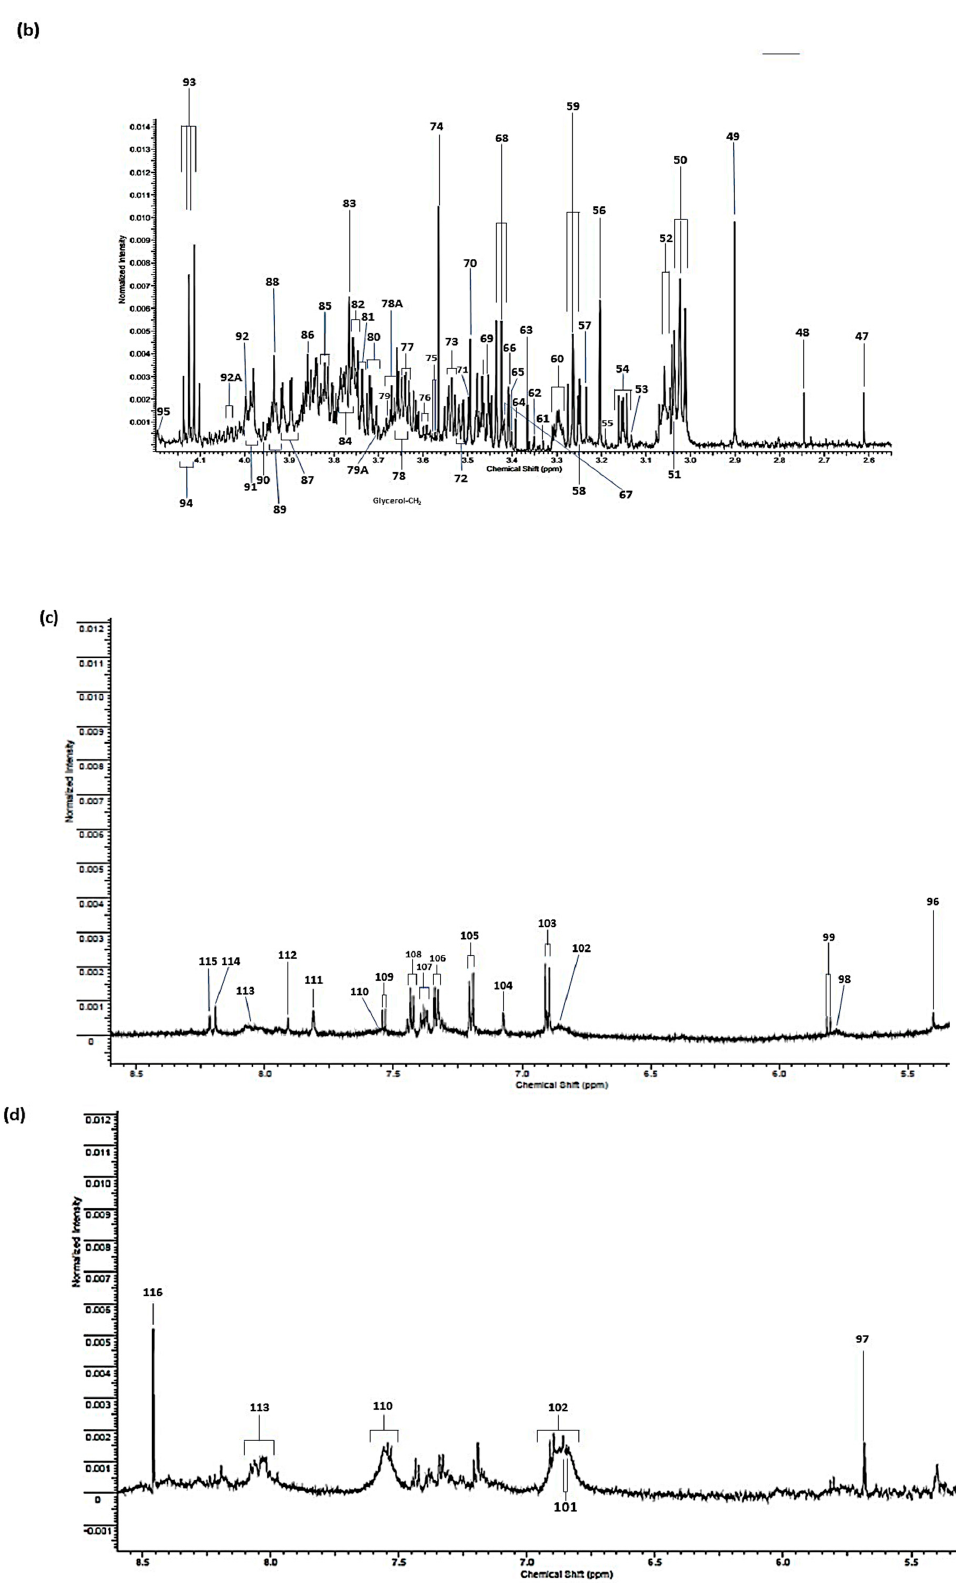
Figure 1. Partial 1 H NMR profiles of a WMS supernatant sample collected from a healthy human participant, stored and prepared for analysis according to our protocols described in Section 6. ( a ) and ( b , c ) show the 0.80–2.50, 2.55–4.20, and 5.30–8.60 ppm regions of spectra acquired. ( d ) 5.30–8.60 ppm region of the spectral profile acquired on a WMS supernatant collected from a second healthy participant. Abbreviations: Assignment codes correspond to those listed in Table 1. Tentative as- signments only are also indicated in Table 1. Single-pulse 1 H NMR spectra were recorded on a Bruker Avance 600 spectrometer operating at frequency of 600.13 MHz, with a probe operating tem- perature of 20 °C. Spectra were acquired with suppression of the large H 2 O/HOD resonance ( δ = 4.80 ppm) using radiofrequency pulse presaturation. Pulsing conditions were sweep width 8389 Hz; 5 μ s pulses; 1.0 s pulse repetition rate; 32,768 (subsequently zero-filled to 65,536) datapoints; 128 transients. An exponential line-broadening function of 0.30 Hz was applied to FIDs before Fourier transformation. Typical spectra are shown. Although previous 1 H NMR-based metabolomics investigations of PS and SM/SL sa- liva samples have been very restricted in the context of poor spectral resolution, limited numbers of participant donors, and gland inflammation complications for the latter [22,23], Gardner et al. [7] compared the 1 H NMR profiles of PS and SM/SL saliva samples collected from the same donors and concluded that there were no major differences be- tween them. However, although understandable because of collection problems, unlike those experienced with WMS, the relatively limited sample size involved (n = 10) may be insufficient to draw robust conclusions from this, and therefore the authors recommend that a full 1 H NMR-based metabolomics investigation should be performed in order to seek, and possibly confirm and verify, any metabolic differences detectable, if indeed jus- tified. Particularly noteworthy is the phenomenon that, as noted by Gardner et al. [7], the overall physiological significance of salivary metabolites such as short-chain organic acid anions is predominantly unknown. However, in the human colon, such bacterial catabo- lites, e.g., n -butyrate, propionate, lactate, and succinate have been ascribed principal ac- tions in relation to human health. Indeed, these catabolites exert important roles in the maintenance of gut epithelial integrity, especially for n -butyrate, which is known to stim- ulate the tight junction expression and synchronizes colonic epithelial cell proliferation; these processes occur through the inhibition of histone deacetylase inhibition, an upregu- lation of the expression of apoptosis-supporting-genes [24,25], and the ability to exert ac- tions regarding metabolic and immune regulation functions [24,26]. Interestingly, they also play roles in the regulating the satiety and appetite of the host [27].